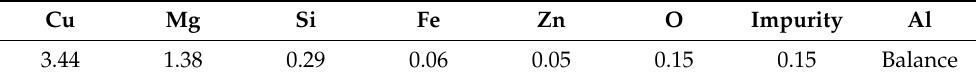
Table 1. Chemical compositions of AA2009 aluminum alloy